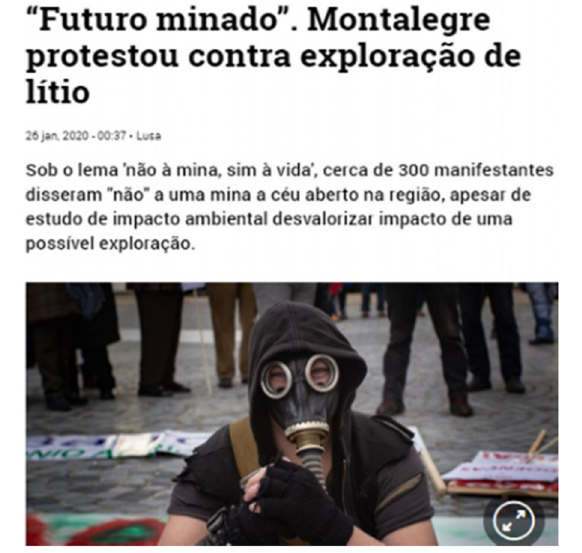
Fig. 1 Newspaper news “Mined Future”. Montalegre has protested against the exploration of lithium. Source: [57] https:// rr. sapo. pt/ notic ia/ pais/ 2020/ 01/ 26/ futuro- minado- monta legre- prote stou- contra- explo racao- de- litio/ 179702/